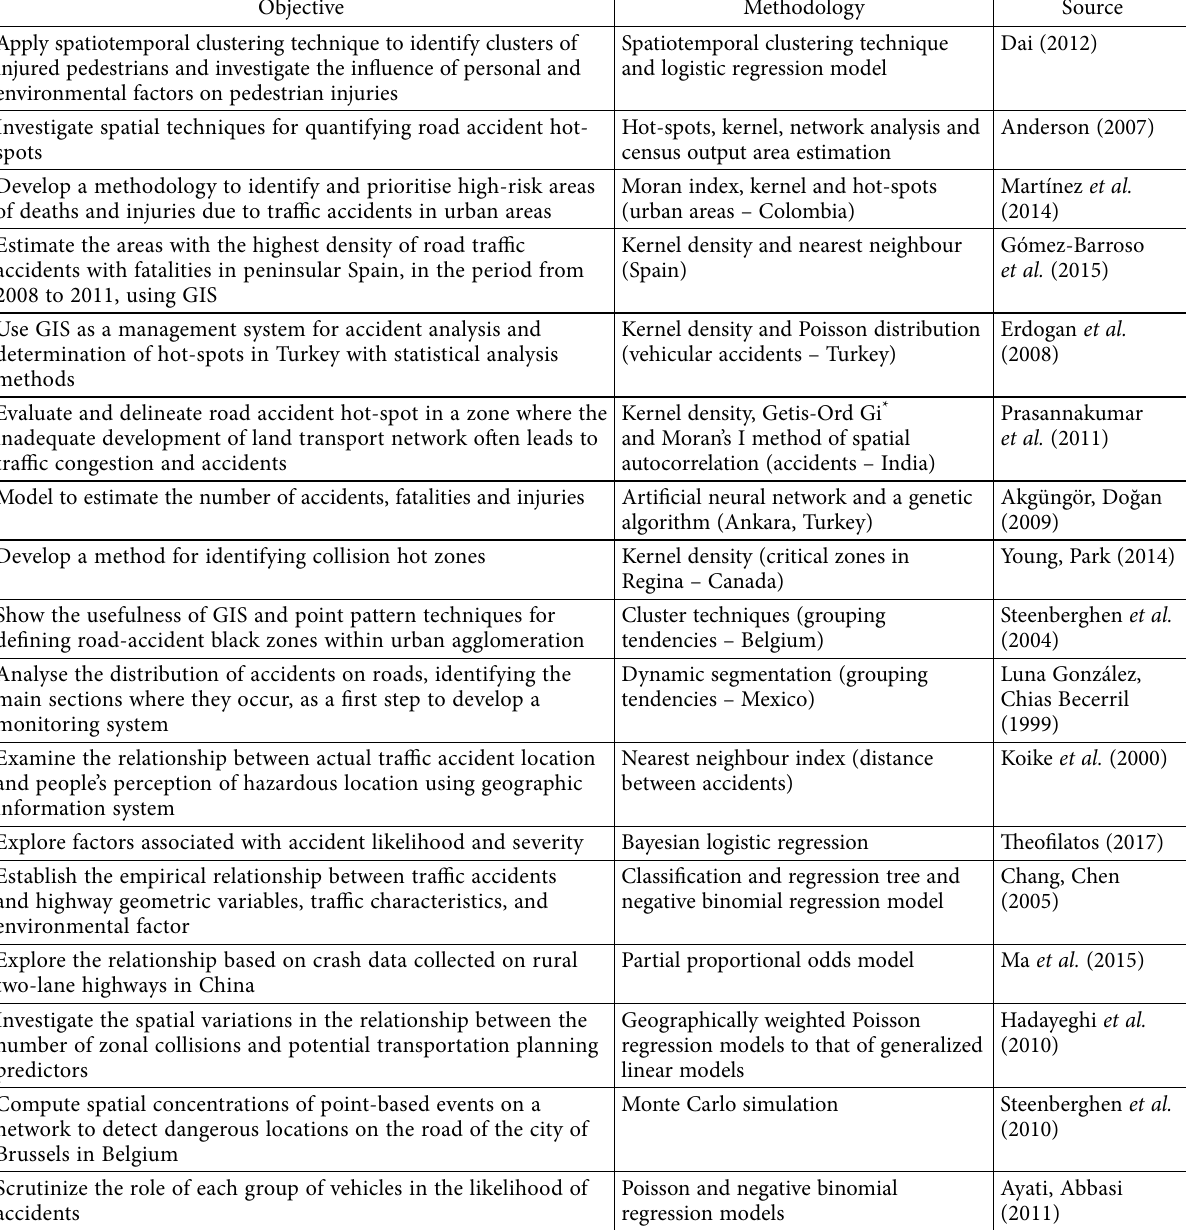
Table 2. Background of methodologies used for road accident